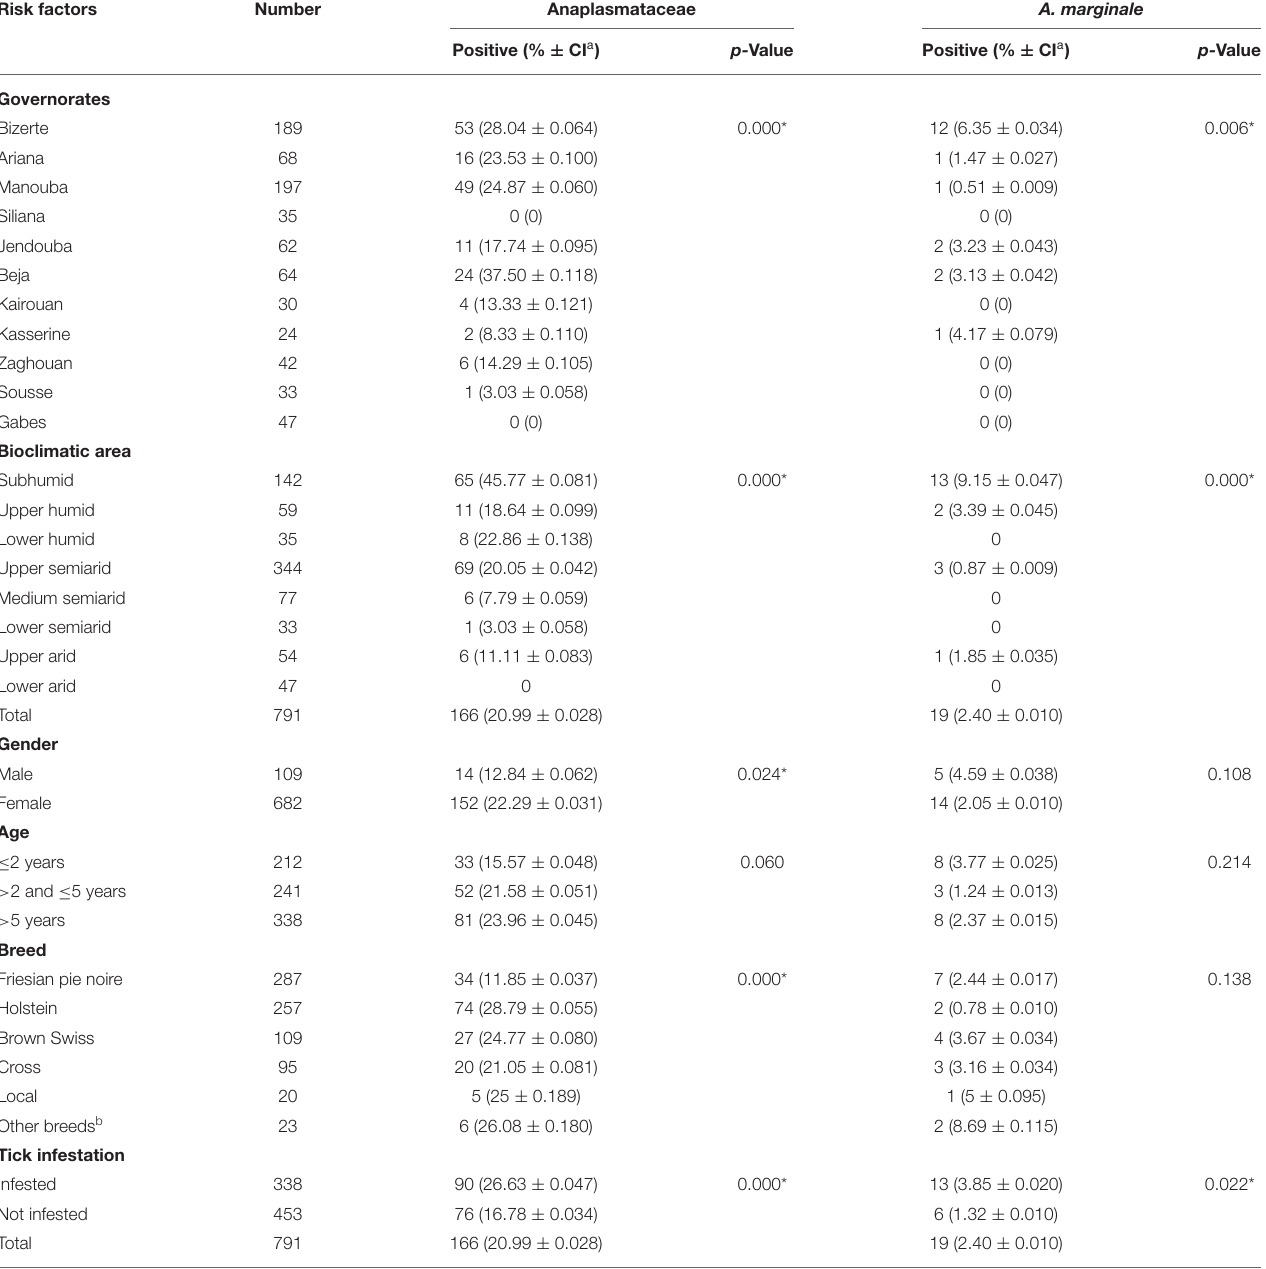
TABLE 1 | Molecular prevalence rates of Anaplasmataceae and Anaplasma marginale according to geographic, bioclimatic, and cattle-related risk factors. Risk